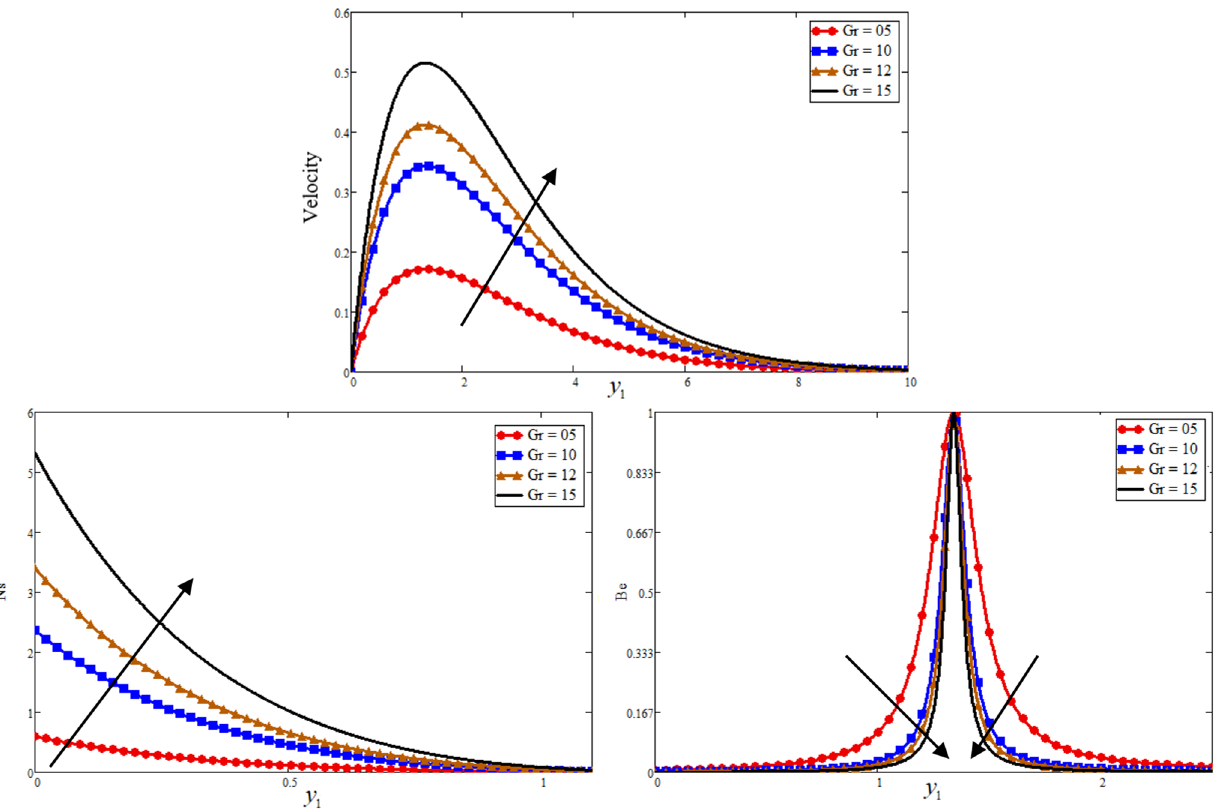
Figure 3. Effect of Gr Bejan number, entropy generation, and velocity.